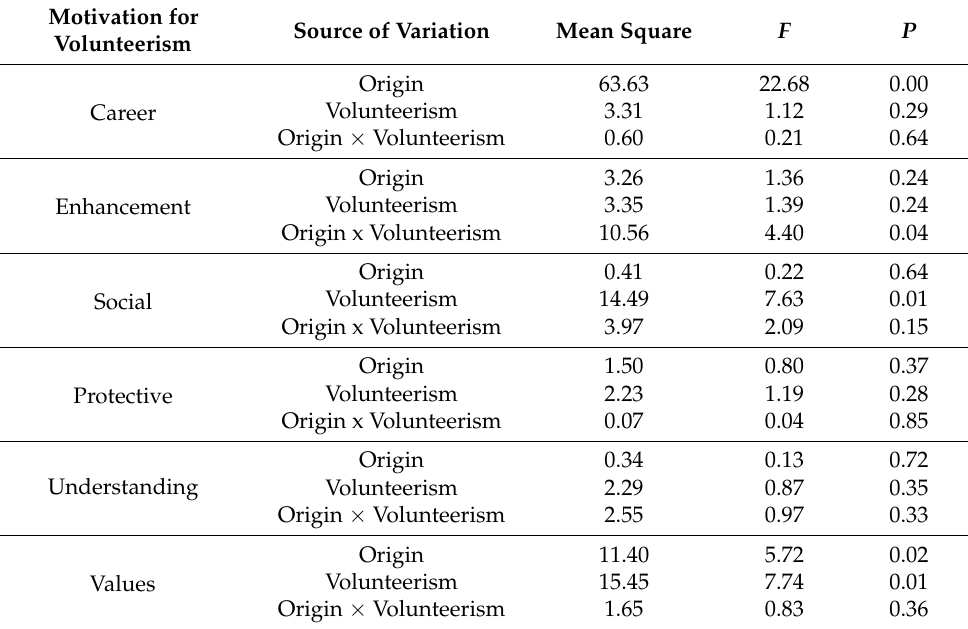
Table 2. Findings of two-way ANOVA regarding motivation for volunteerism according to country of origin and actual volunteer activity ( N =